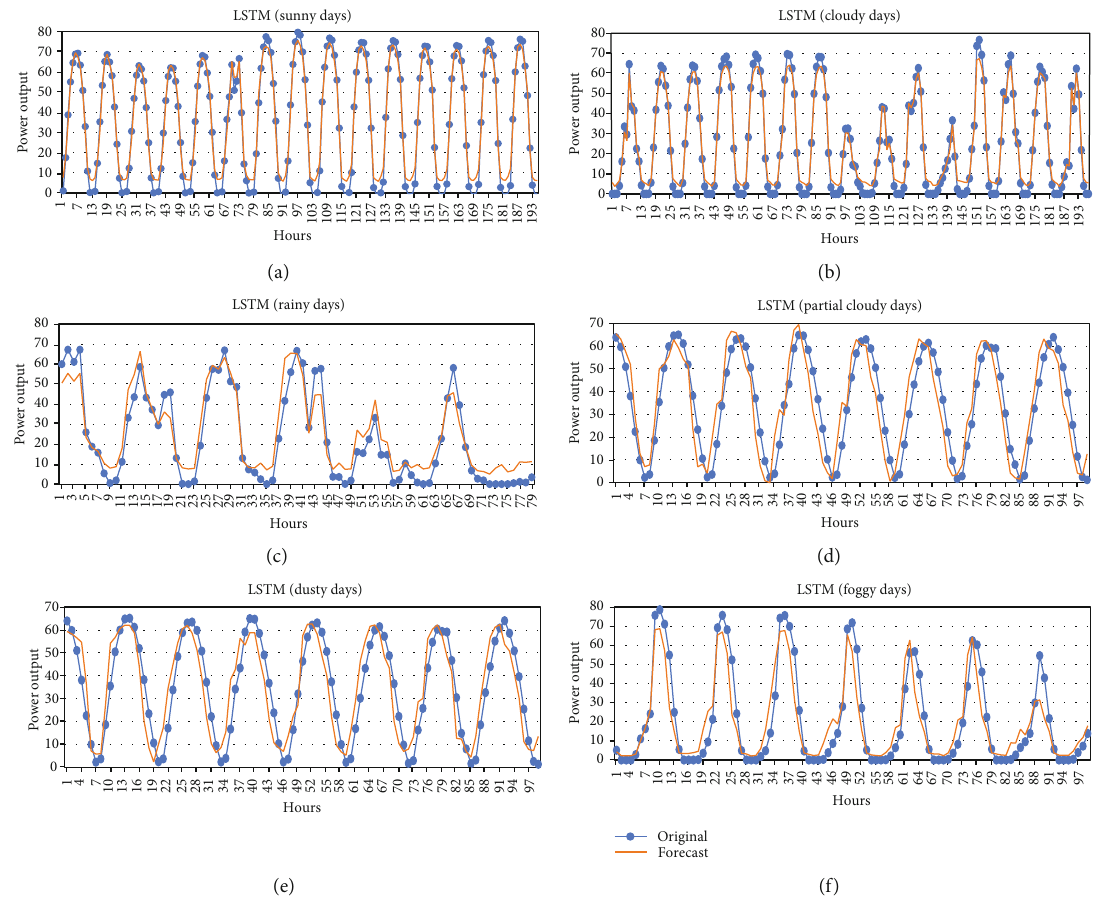
Figure 4: LSTM results for (a) sunny days, (b) cloudy days, (c) rainy days, (d) partial cloudy days, (e) dusty days, and (f) foggy